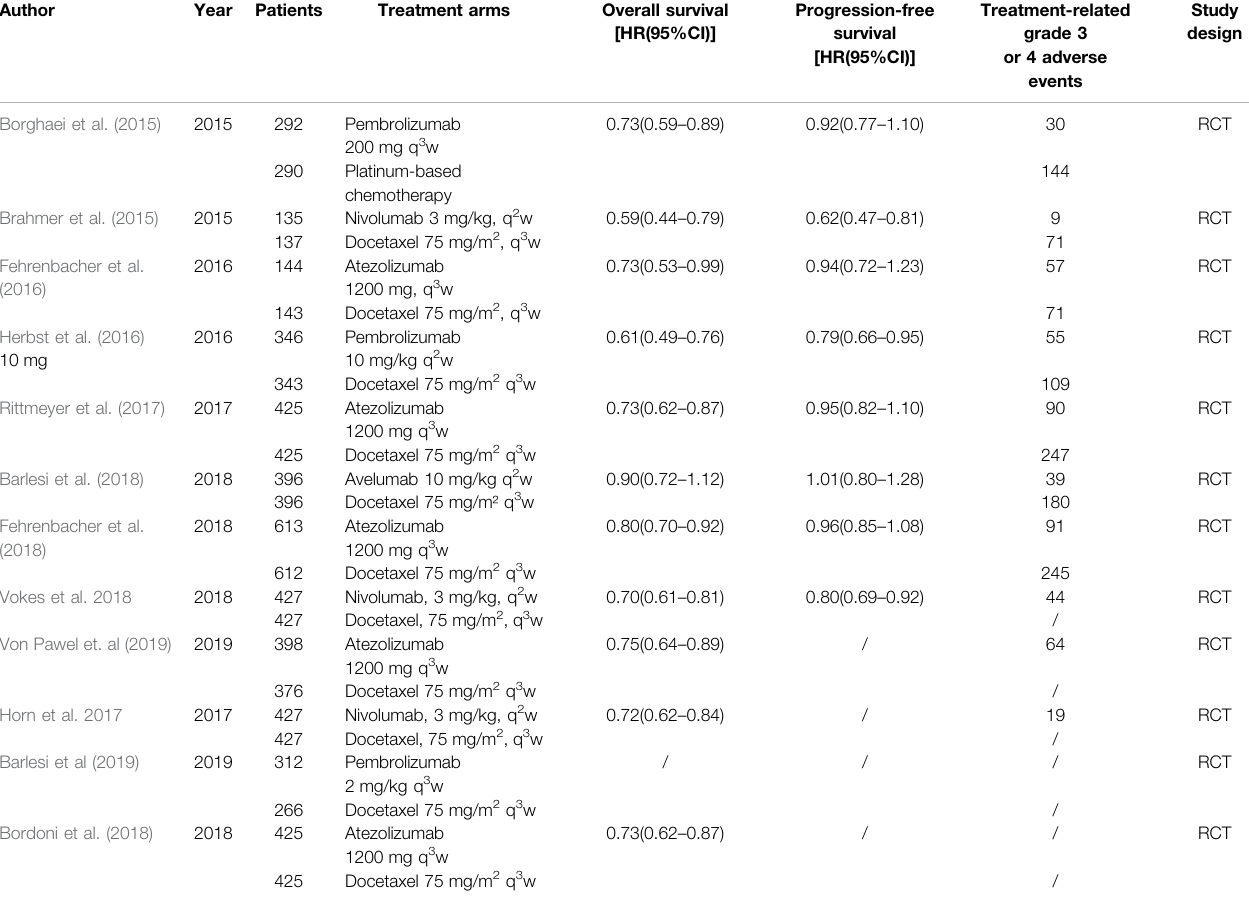
TABLE 1 | Basic characteristics of the